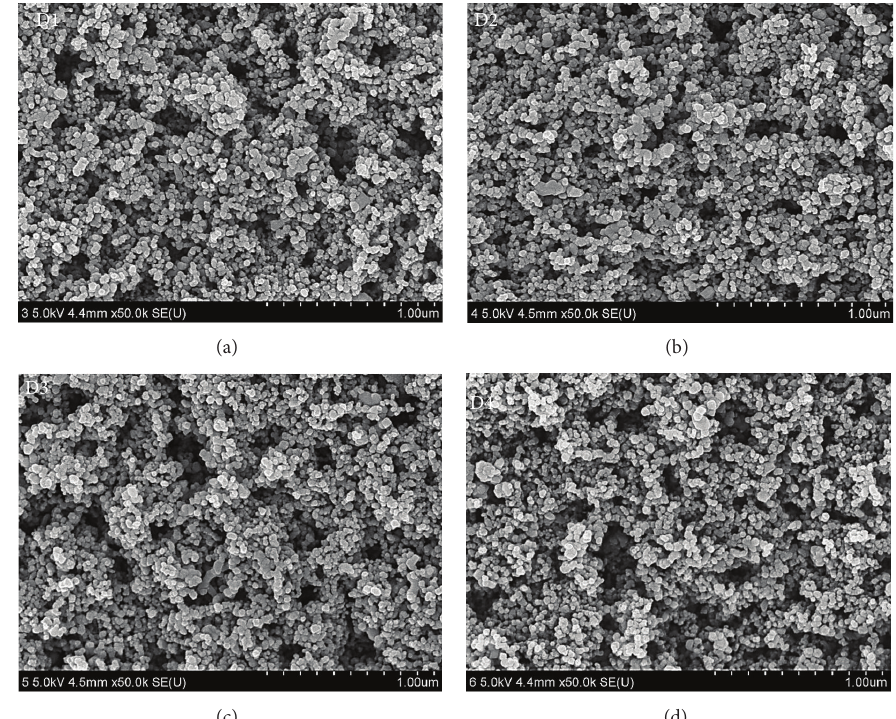
Figure 2: FE-SEM images of the surface morphologies of chitosan sol-based TiO 2 films.